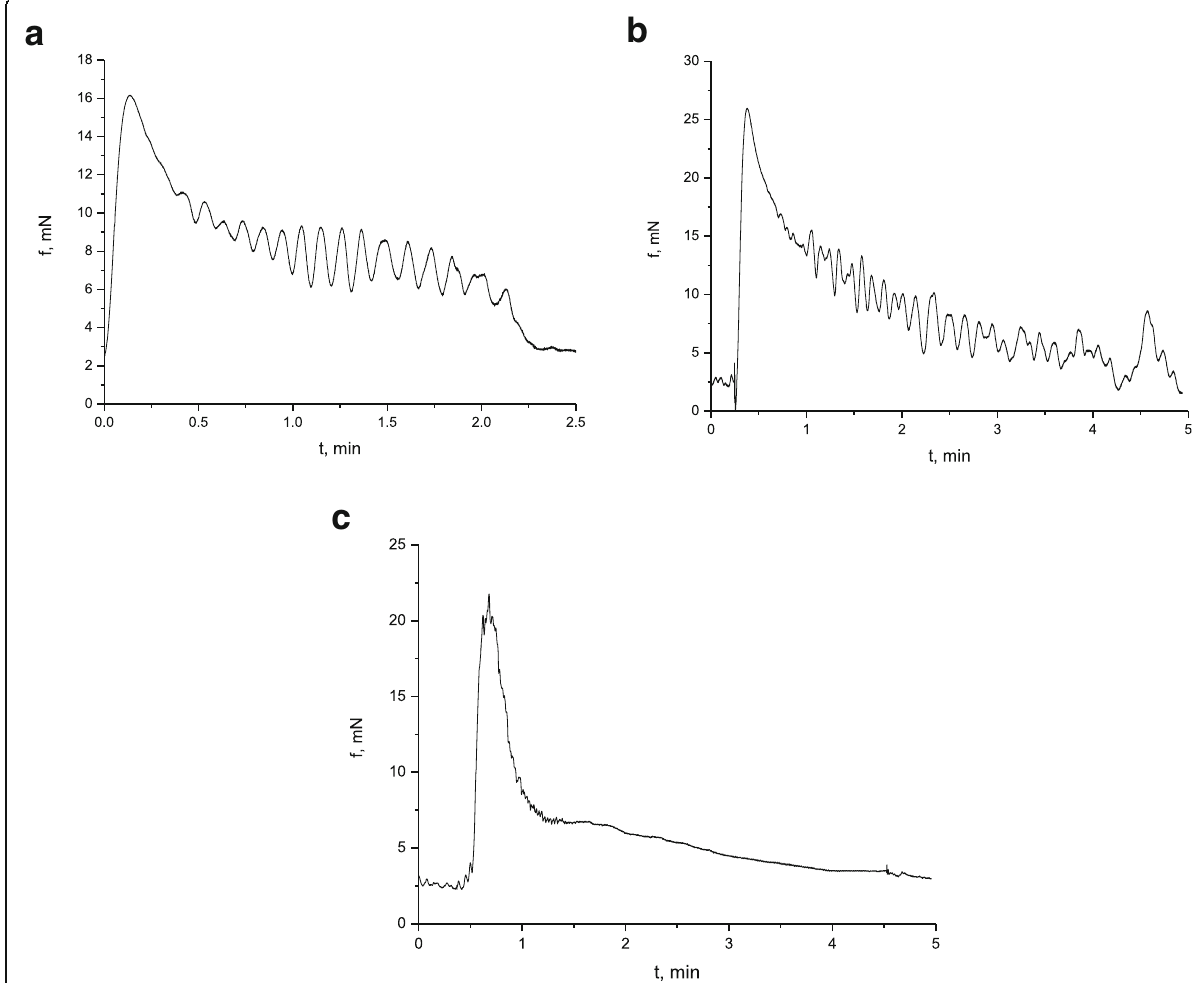
Fig. 5 Acetylcholine-induced (10 − 5 mol/l) contraction of circular smooth muscles of the caecum of the rats in the control group ( a ) and the group of rats, burdened with the suspension of titanium dioxide for 30 days ( b ) and 100 days ( c